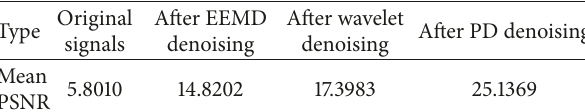
Table 4: Mean P-wave